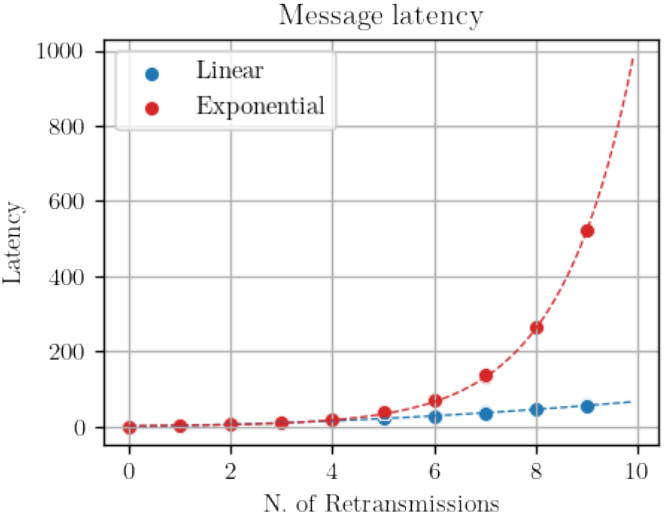
Figure 4. Message latency in function of the number of retransmissions using different packet error rates in the simulations.